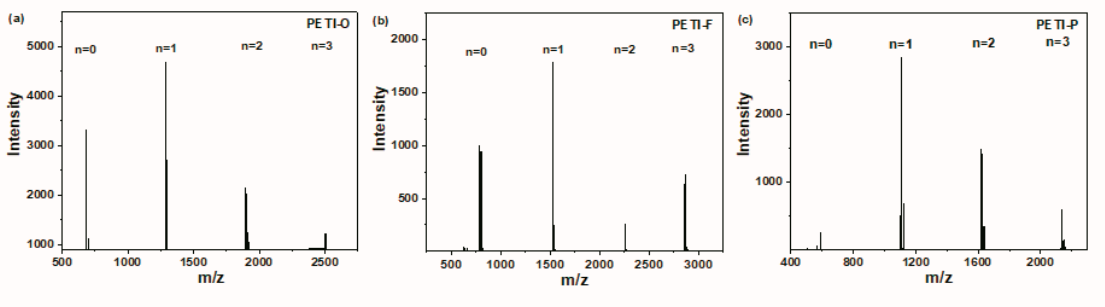
Figure 2. ( a ) MALDI-TOF mass spectrum of PETI-O; ( b ) MALDI-TOF mass spectrum of PETI-F; ( c ) MALDI-TOF mass spectrum of PETI-P.